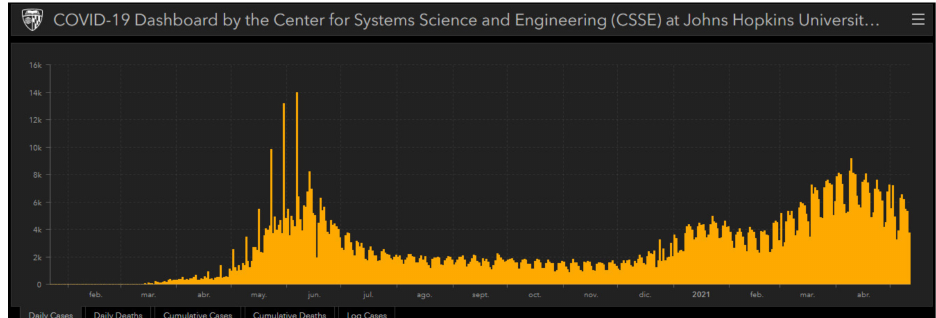
Figure 1. SARS-CoV-2 daily cases in